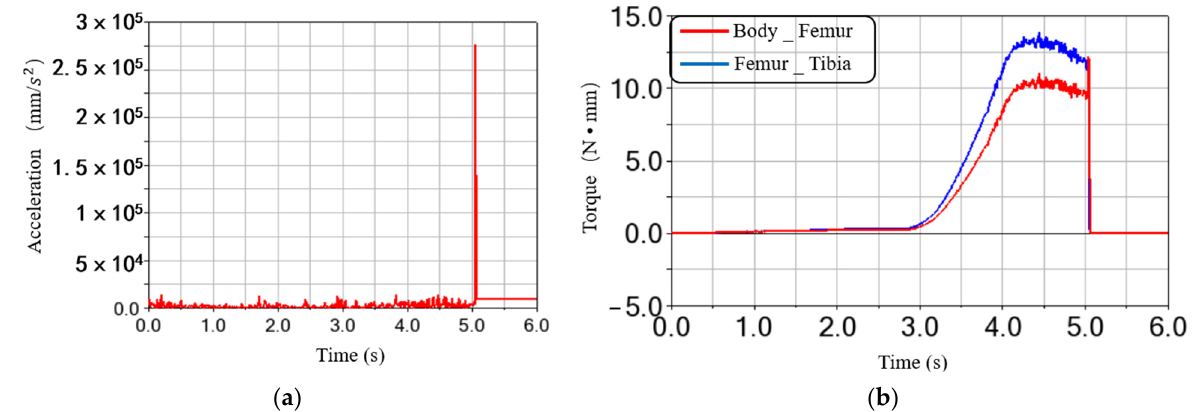
Figure 11. ( a ) Acceleration of the robot’s center of mass; ( b ) Graph of torque change during the jumping phase.